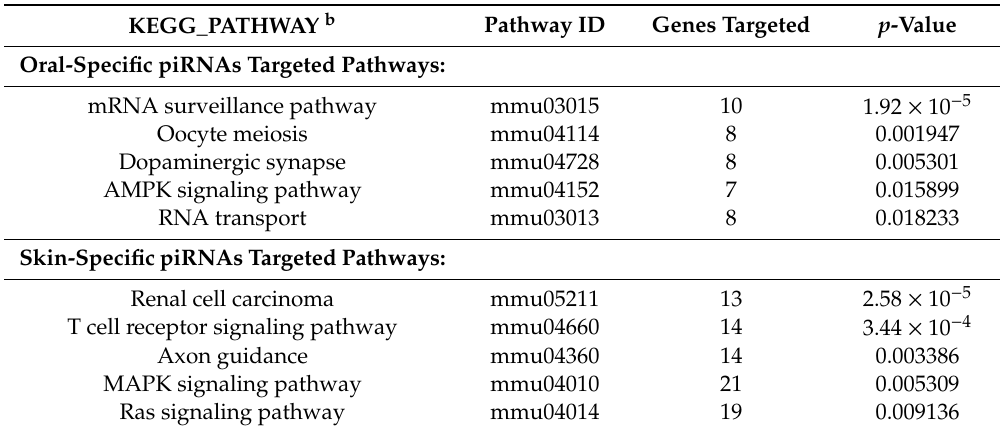
Table 1. Bioinformatic prediction of molecular pathways regulated by tissue-specific di ff erentially expressed piRNAs a